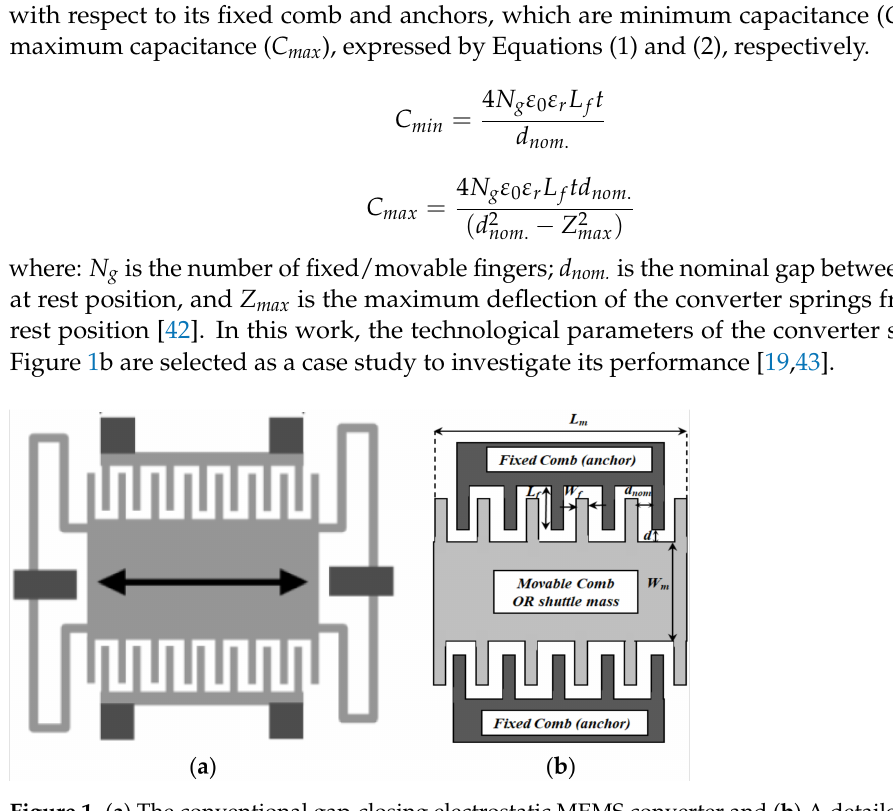
Figure 1. ( a ) The conventional gap-closing electrostatic MEMS converter and ( b ) A detailed descrip- tion of the converter comb drive parameters